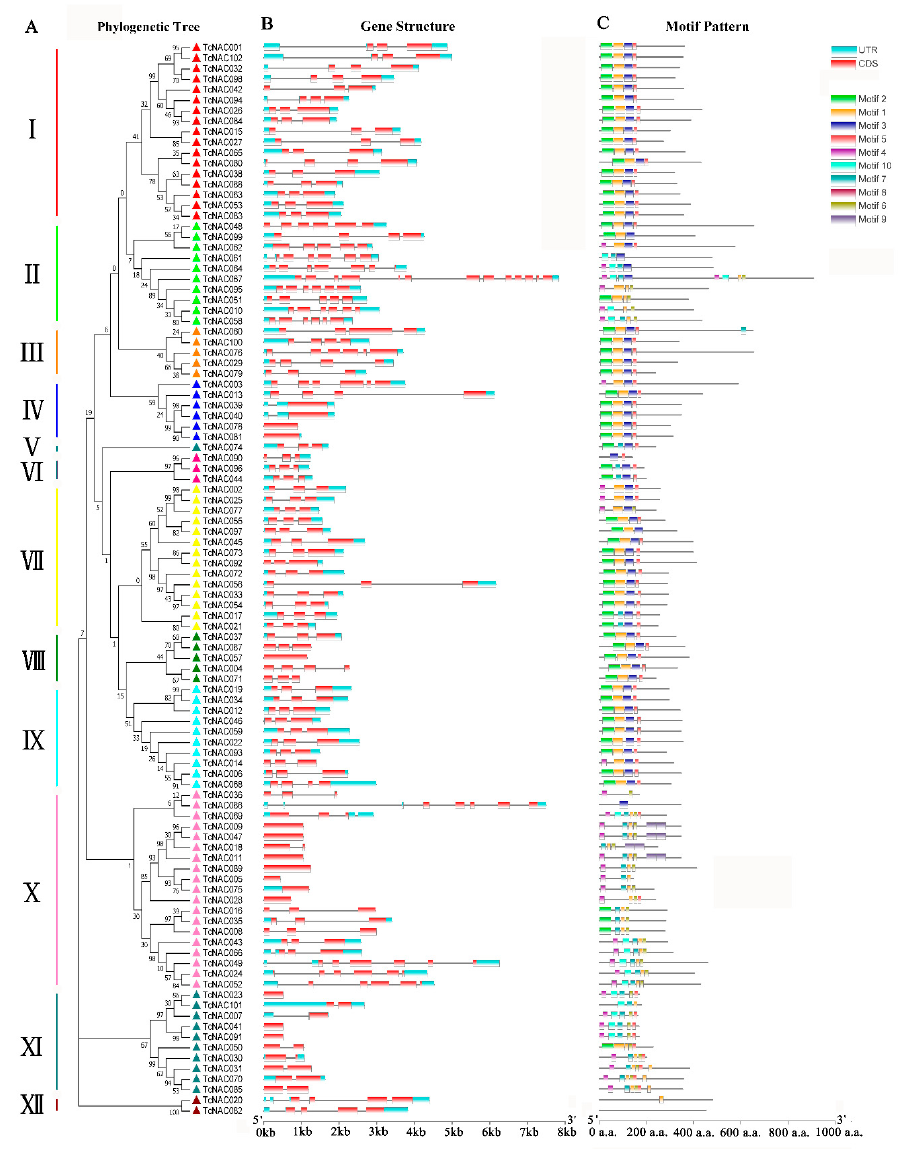
Figure 2. Phylogenetic relationships, gene structure and architecture of conserved protein motifs in NAC genes from Theobroma cacao . ( A ) The phylogenetic tree was constructed based on the full-length sequences of Theobroma cacao NAC proteins using MEGA 7.0 software. ( B ) Exon–intron structure of Theobroma cacao NAC genes. Blue boxes indicate untranslated 5 ′ - and 3 ′ -regions, red boxes indicate exons, and black lines indicate introns. ( C ) The motif composition of Theobroma cacao NAC proteins. The motifs are displayed in different colored boxes. The sequence information for each motif is provided in Supplementary File 3. The length of the protein can be estimated using the scale at the bottom.